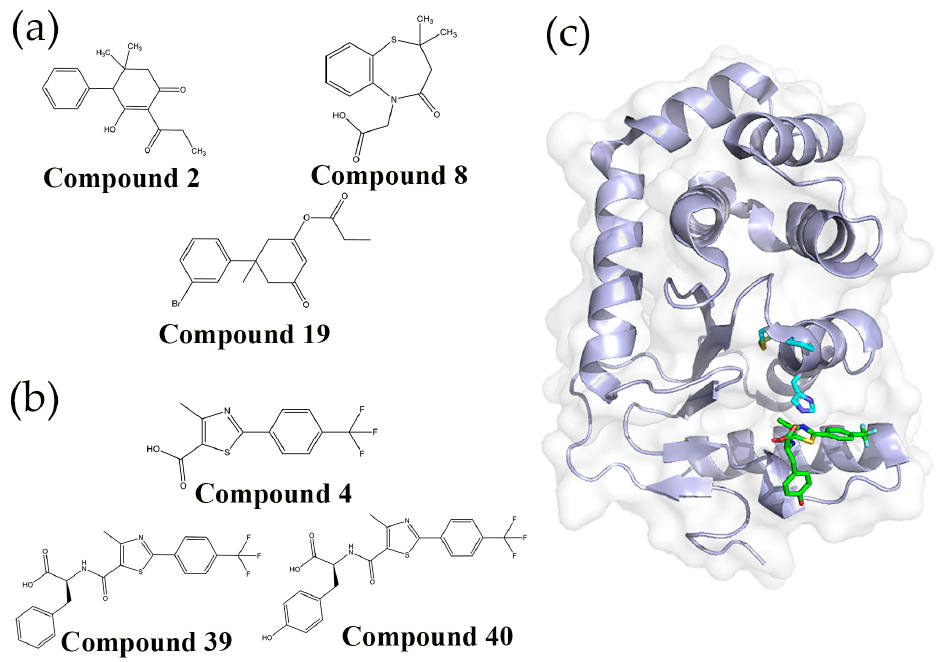
Figure 4. ( a ) Potent DsbB inhibitors identified by a fragment-based drug discovery (FBDD) method. Compound 2 (6-hydroxy-2,2-dimethyl-5-propionyl-2,3-dihydro-[1,1 ′ -biphenyl]-4(1 H )-one) has the same binding site as UQ1, compound 8 (2-(2,2-dimethyl-4-oxo-3,4-dihydrobenzo[ b ][1,4]thiazepin-5(2 H )-yl)acetic acid) competes with both quinone and EcDsbA for binding EcDsbB. Compound 19 (3 ′ -bromo-1-methyl-5-oxo-1,2,5,6-tetrahydro-[1,1 ′ -biphenyl]-3-yl propionate) is the small molecule DsbB inhibitor developed from compound 2 ; ( b ) Structures of compound 4 (4-Methyl-2-(4-(trifluoromethyl)phenyl)thiazole-5-carboxylic acid) the most potent DsbA inhibitor identified by a FBDD method, and a phenylalanine derivative (compound 39 , 4-Methyl-2-(4-(trifluoromethyl)phenyl)thiazole-5-carbonyl)- L -phenylalanine) and a tyrosine derivative (compound 40 , 4-Methyl-2-(4-(trifluoromethyl)phenyl)thiazole-5-carbonyl)- L -tyrosine); ( c ) Co-crystal structure of compound 40 bound to EcDsbA (PDB 4WET). The CPHC active site and cis -Pro residue are displayed in stick representation (cyan). Compound 40 is shown in stick representation with carbon atoms colored green.